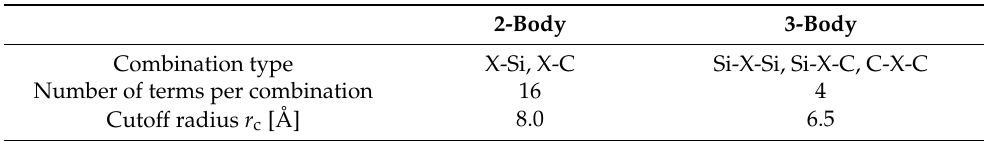
Table 1. Architectural parameters of basis function set. X in the combination type indicates the atomic species of centering atom (X = Si,